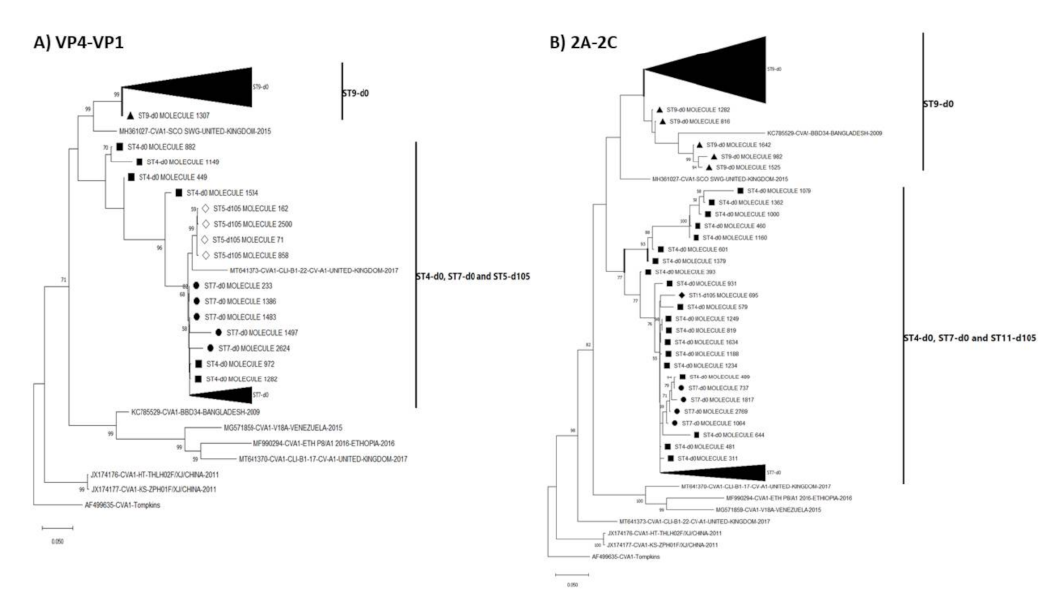
Figure 4. Maximum likelihood phylogenetic tree of CVA1 ( A ) VP4-VP1 [from assay 3a contigs] and ( B ) 2A-2C [from assay 3b contigs] genomic regions. The phylogenetic trees are based on an alignment of CVA1 contigs recovered from assay 3a and 3b (LRISW) in this study and those present in GenBank. The contigs are coded based on the sampling sites and days. Filled triangle, circle, square and diamond represent ST9-d0, ST7-d0, ST4-d0 and ST11-d105, respectively. ST5-d105 is denoted using empty diamond. Bootstrap support is shown if >50. Abbreviation: ST = site. Please note that the region amplified in the SSW is present in the contig used for making the tree in Figure 4A but not in Figure 4B. Specifically, all VP1 portions of amplicon 3b were removed from the contigs used to make the tree in Figure